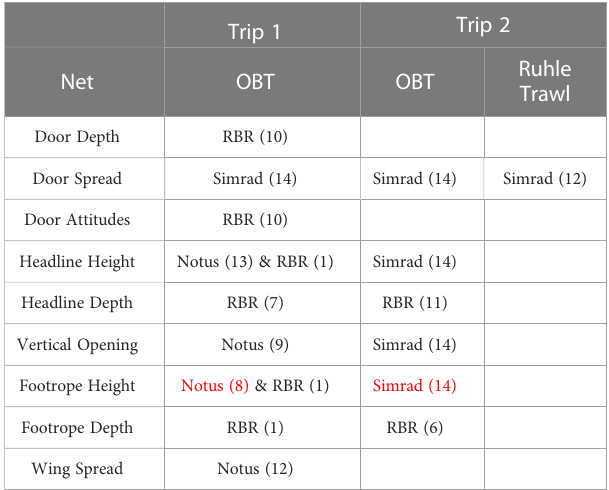
TABLE 1 Net mensuration sensors used during each trip and for each net towed and their associated measured